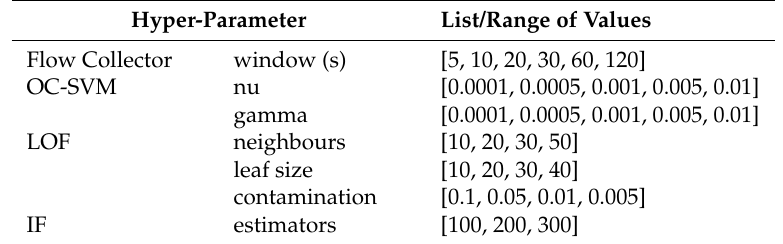
Table 4. Hyper-parameters tuned in the selection process of the the anomaly detection